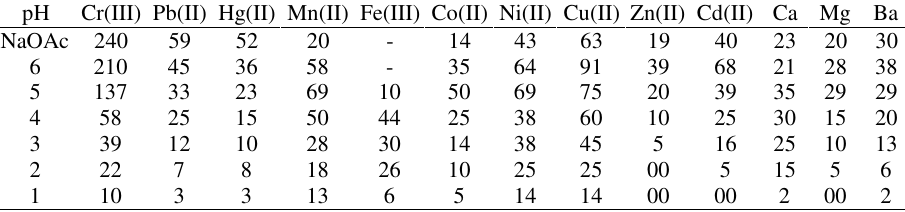
Table 1. Metal capacity values determined in µ mol g